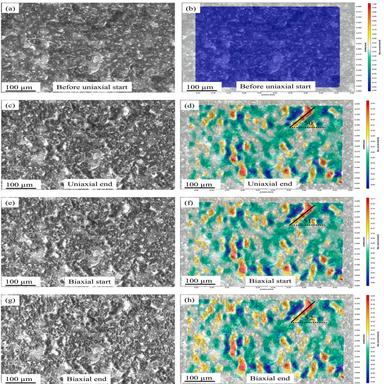
Micrographs of the centre of the AA5182-O specimen at (a) before uniaxial start, (c) uniaxial end, (e) biaxial start and (g) biaxial end during the strain path transition. Corresponding x-axis micro-strain (ex) distribution calculated from micro DIC analysis at (b) before uniaxial start, (d) uniaxial end, (f) biaxial start and (h) biaxial end during the strain path transition.